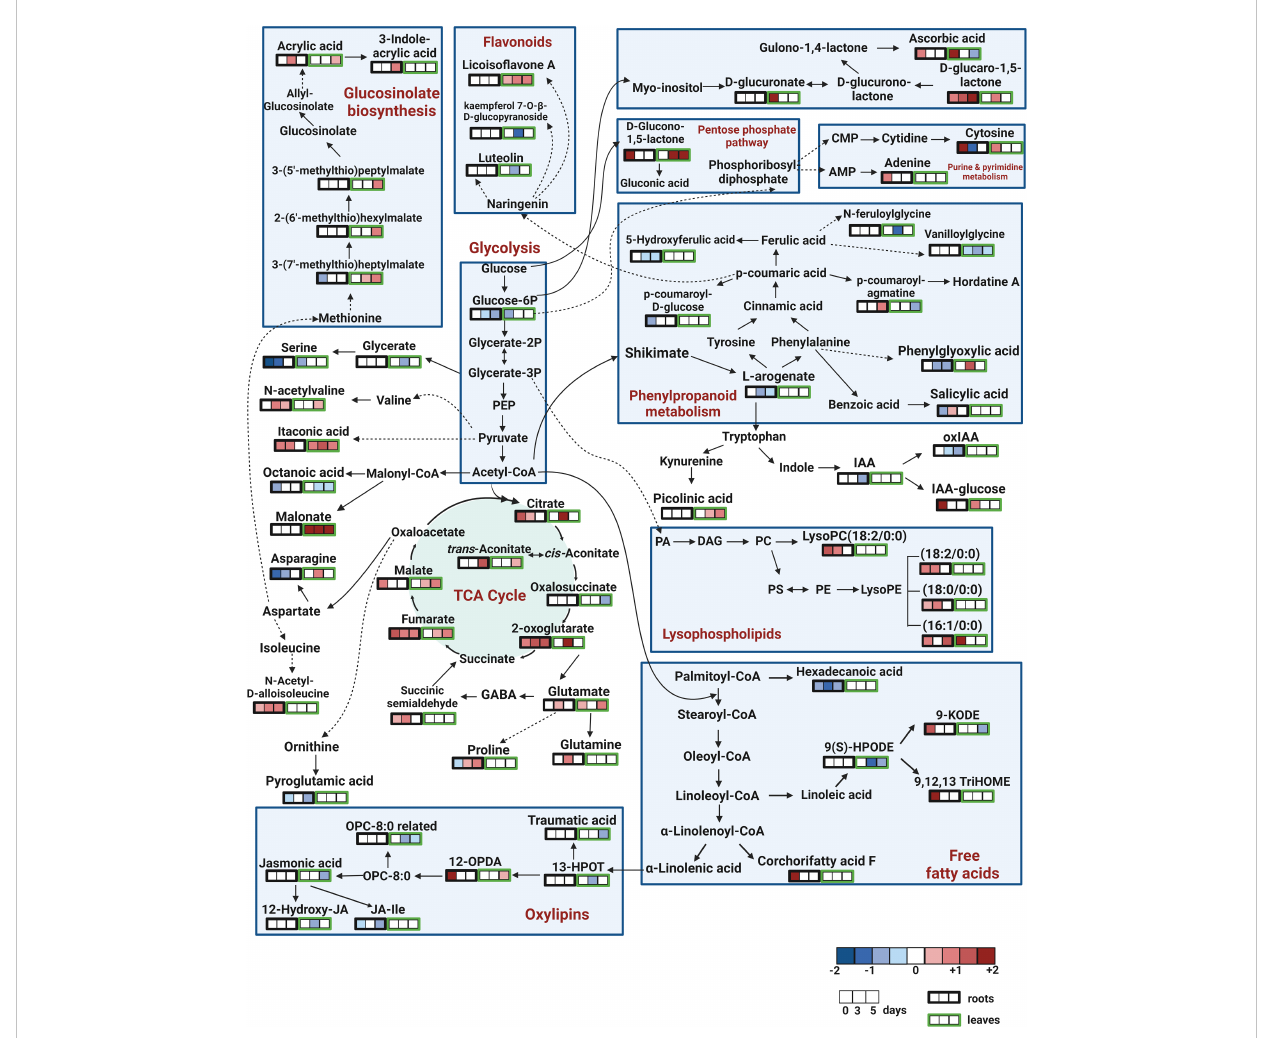
FIGURE 8 Pathway analysis of metabolites that altered in roots and leaves at day 0, day 3 and day 5 following SWE treatment. Out of 89 compounds of interest, 62 compounds were found in the KEGG pathway database, which was used to create this fi gure. The remaining 27 compounds are not shown in the fi gure. Log 2 FC data were used to represent the accumulation of the compounds (red color), or reduced accumulation (blue color), or no statistical change (white) of